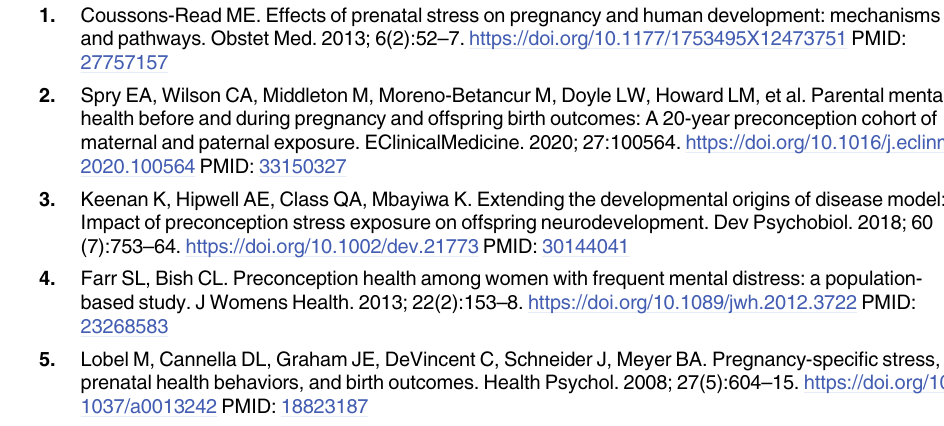
S2 Table. Comparison of characteristics of women with and without missing data. S3 Table. Associations between pregnancy intention and psychological distress by level of COVID-19 transmission rates and lockdown restrictions based on complete case analysis (non-imputed data), N =